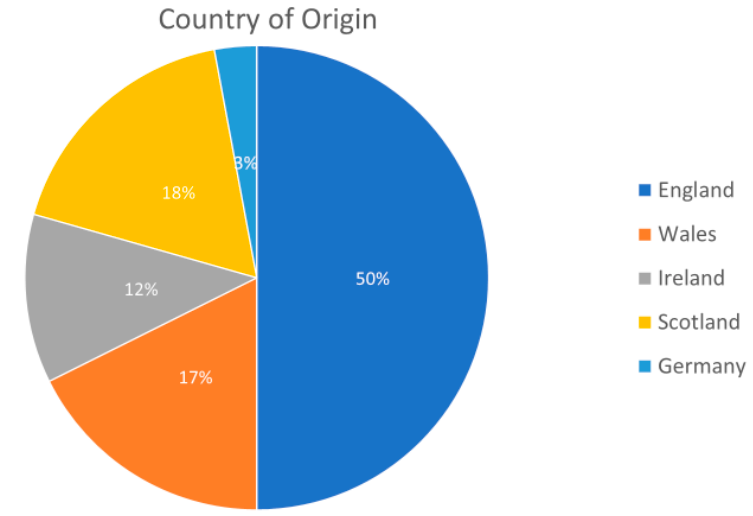
Figure 2. Pie chart showing the distribution of extracted articles by country of origin ( N = 34).